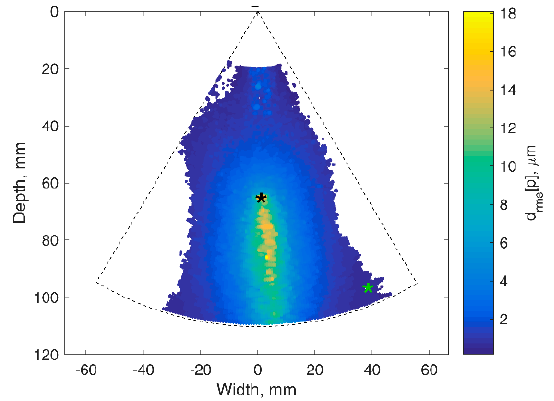
Figure 5. Confidence mapping of displacements in harmonic excited TMM: locations of confident ( p ≤ 0.001) displacements root mean square in color scale. Asterisks in the graph indicates the points in which weak (green asterisk) and intense (black asterisk) displacement signals were estimated.